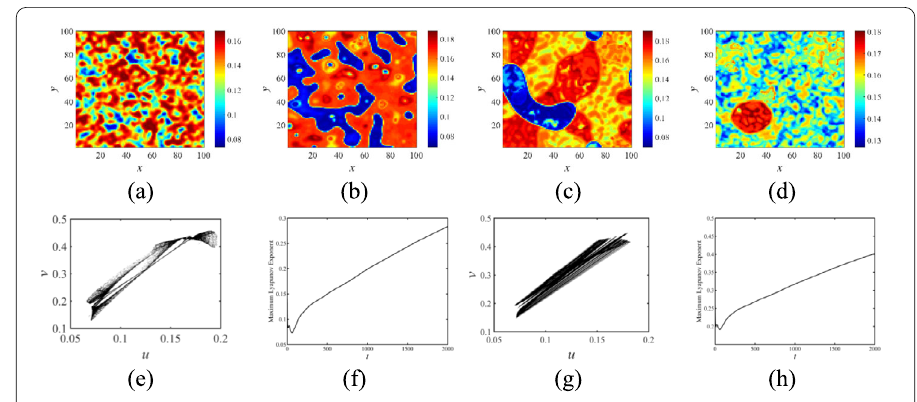
Figure 9 Self-organziation and nonlinear properties of a complex pattern induced by flip–Turing instability. ( a )–( d ) Evolution of the prey pattern at transient times t = 10, t = 100, t = 1000, and t = 10,000, respectively; ( e )–( h ) phase portraits and maximum Lyapunov exponent diagrams in the cases of uncoupling and coupling the population diffusion. The parameter values are given as a = 1.11, e 1 = 0.31, e 2 = 0.21, b = 1.21, τ = 3.15, δ = 2, h = 15, n =